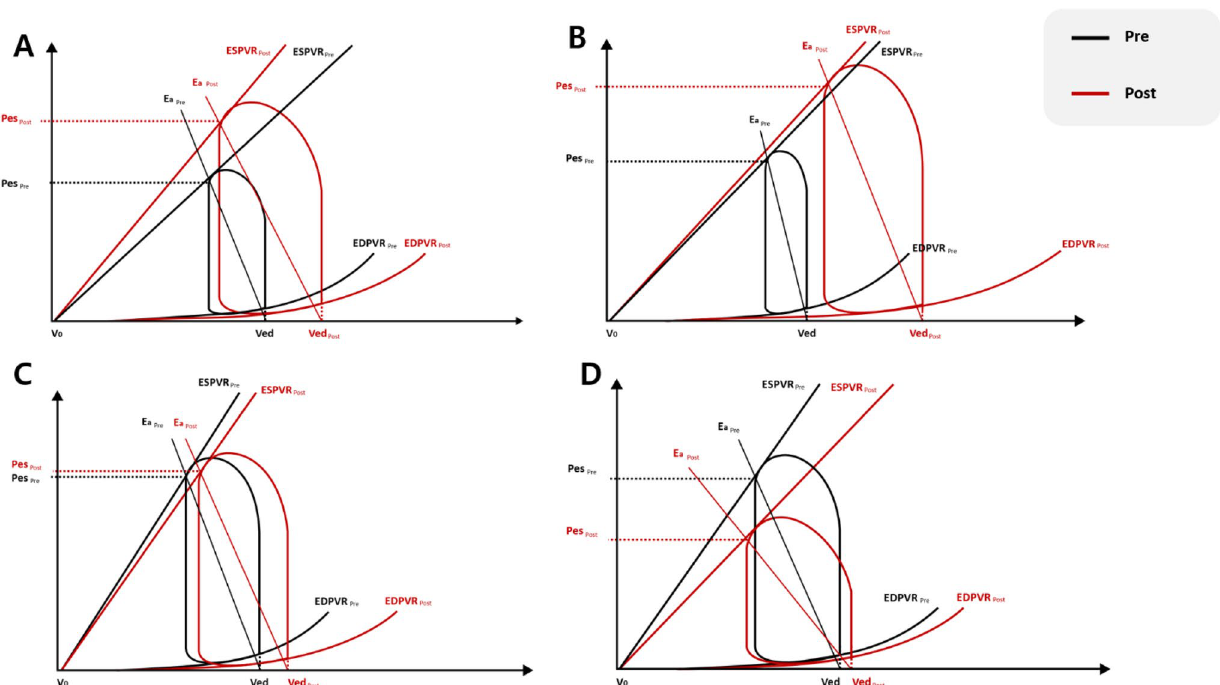
Figure 3. Pressure–volume (PV) loop in each group. The black line represents the baseline PV loop (pre), and the red line represents the PV loop at the end of the experiment. (post). ( A ) PV loop in Group 1. While EDV, ESP, SV, SW, Ees (slope of ESPVR), and PVA increased significantly, the EDP (each point of EDPVR) showed a significant decline after 2 h of ECMO. ( B) PV loop in Group 2. A significant increase in EDV, ESV, ESP SW